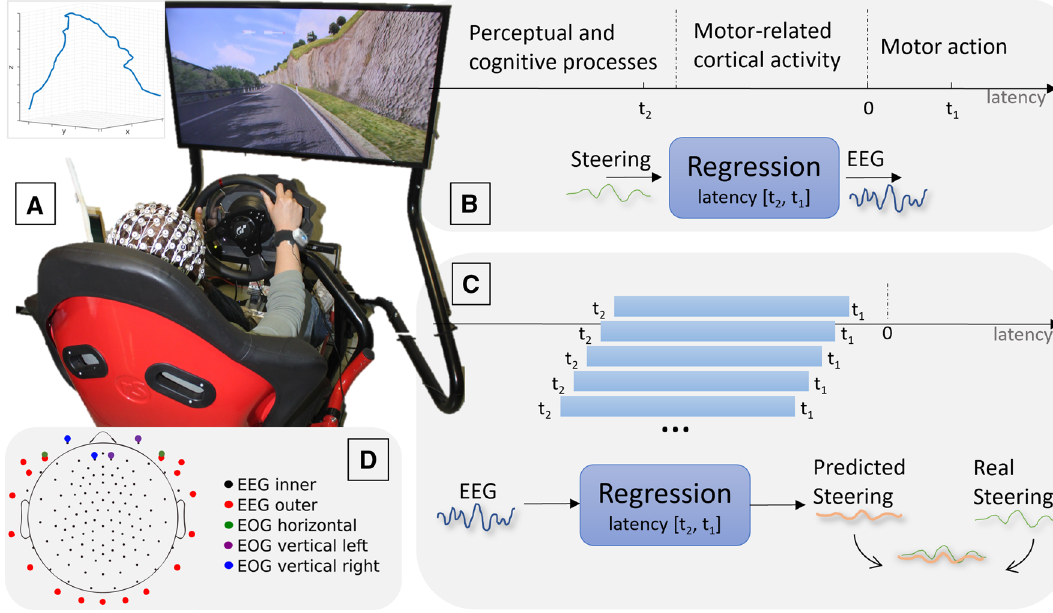
Figure 1. Experimental setup and analysis framework. ( A ) Experimental Setup. Subject performing the experiment inside the racing simulator (Assetto Corsa). Top-left a 3D plot of the track is shown. ( B ) Encoding Model. Lagged linear regression (LLR) encoding models were fit to estimate EEG dynamics preceding and following steering actions with a steering-EEG latency window from –1.5 s (t2) to 0.5 s (t1). ( C ) Decoding model. LLR decoding models were fit to predict the steering position from preceding EEG data at latencies between t2 and t1, with progressive longer anticipations and a fixed window-size of 1.5 s. The quality of the predicted steering signal was assessed with Pearson’s correlation. ( D ) EEG-layout. EEG 128-channels location divided by colours (black thin dots are the inner electrodes used for LLR).